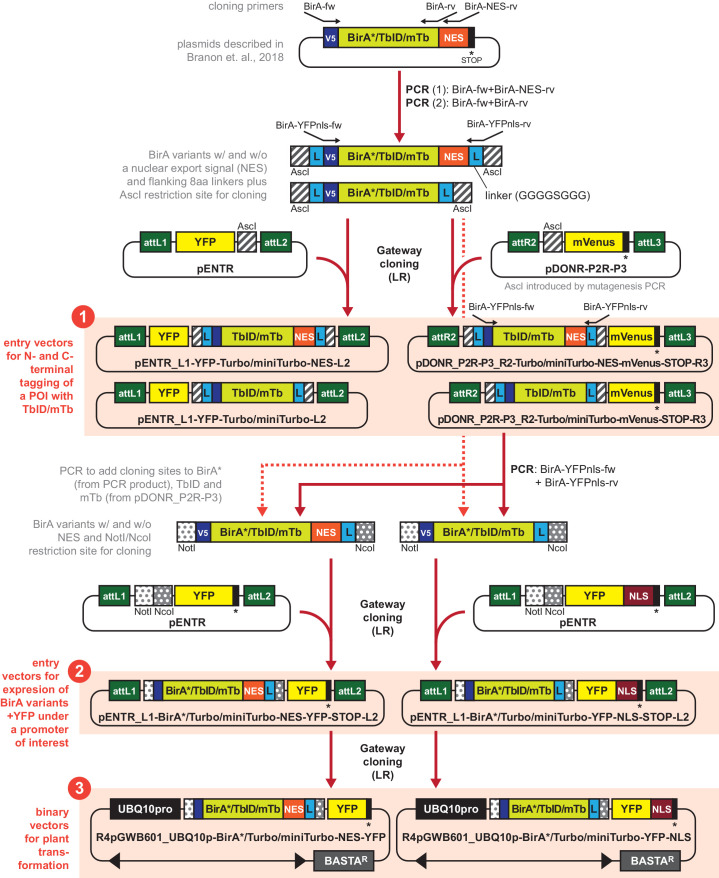
Generating a toolbox of gateway-compatible vectors for PL in plants.Schematic overview over cloning steps involved in the generation of the PL toolbox and over the available vectors (highlighted as orange boxes). Analogous constructs for different biotin ligase variants are summarized (indicated by BirA*/TbID/mTb or TbID/mTb). Primers and restriction sites used for PCR and restriction cloning are indicated on the top or bottom of the constructs. V5 = V5 tag, L = 8 amino acid linker (GGGGSGGG), NES = nuclear export signal, NLS = nuclear localization signal, POI = protein of interest. Available plasmids include: ❶ eight entry vectors for N- and C-terminal tagging of proteins of interest with TbID or mTb plus a fluorophore, ❷ six entry vectors for expressing any of the three BirA variants under a promoter of interest with a NES or NLS and a fluorophore, and ❸ six binary plant transformation vectors for expressing any of the three BirA variants with an NES or NLS under the UBQ10 promoter. A detailed description and primer sequences are included in the Materials and methods section. A list of available plasmids with Addgene catalogue number can also be found in the Materials and methods section.